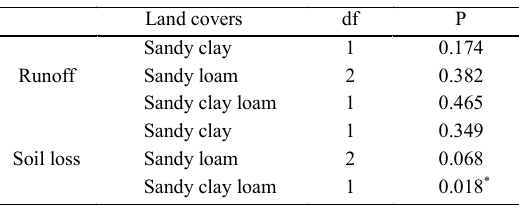
Table 9: The results of Kruskal-Wallis test on land covers and runoff and soil loss in each soil texture